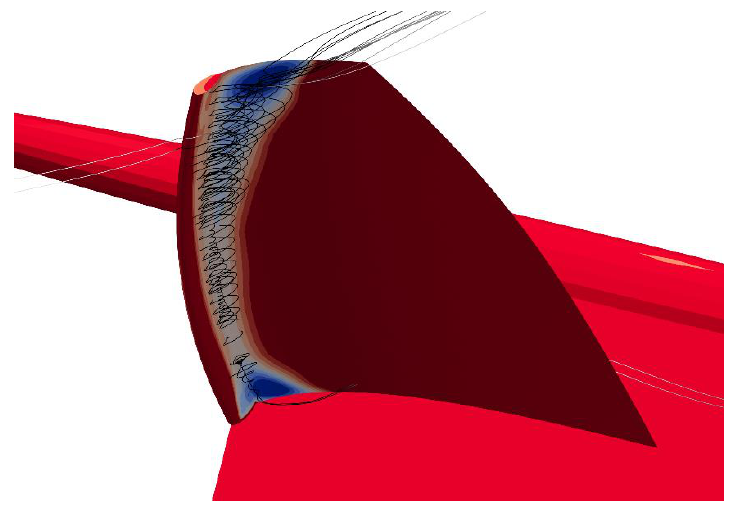
Figure 19. Evolution of separations behind the mast on a traditional A-Cat rig.